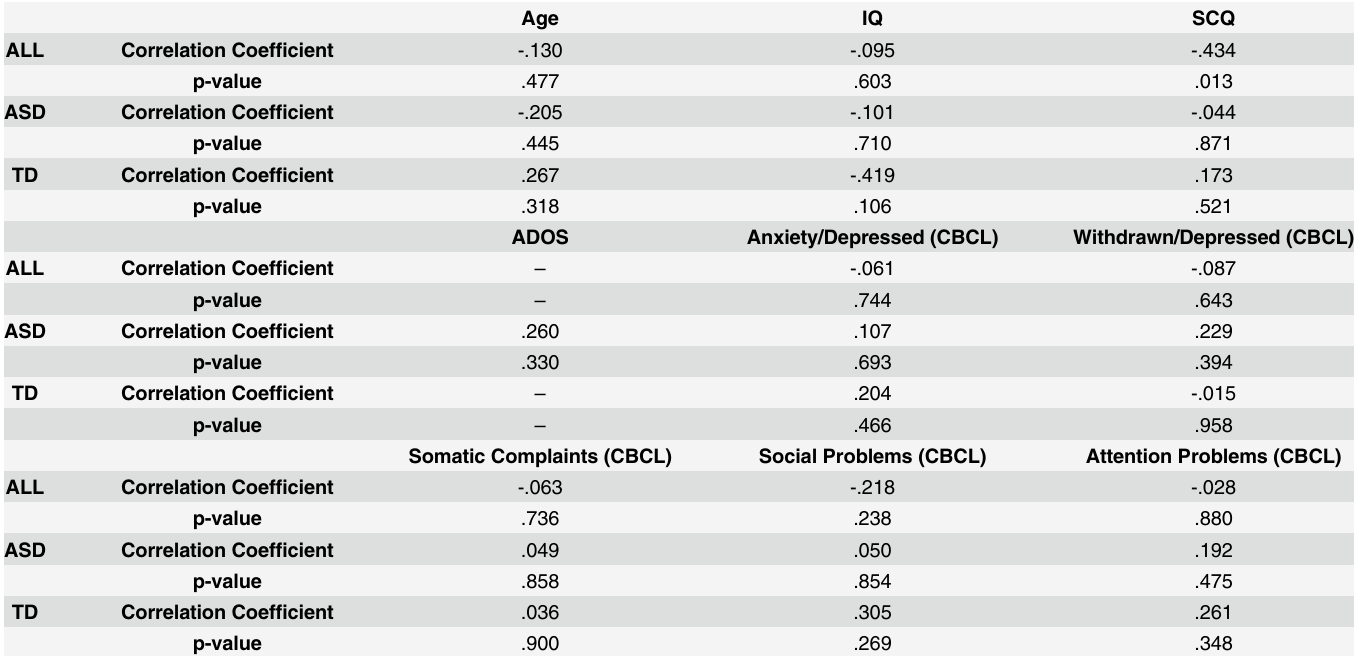
Table 2. Pearson ’ s correlation coefficients between interpersonal distance and age, IQ, autistic traits, and clinical complaints for all participants, the autism spectrum disorder group, and the typically developing